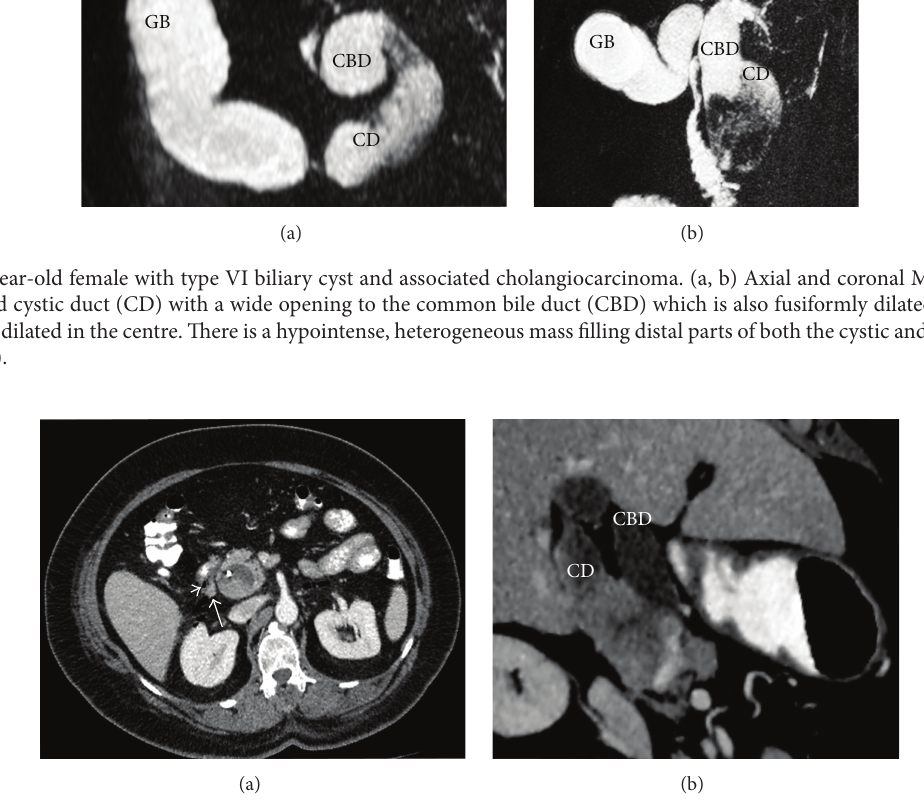
Figure 2: CT examination performed with the suspicion of perforation following ERCP. (a) Axial contrast enhanced CT image shows intraperitoneal free air (short arrow) and periduodenal contrast extravasation (long arrow) suggesting perforation. (b) Multiplanar reconstructed CT image shows fusiform cystic dilatation of the cystic duct having a wide opening to the extrahepatic bile duct which is also fusiformly dilated and the enhancing mass.